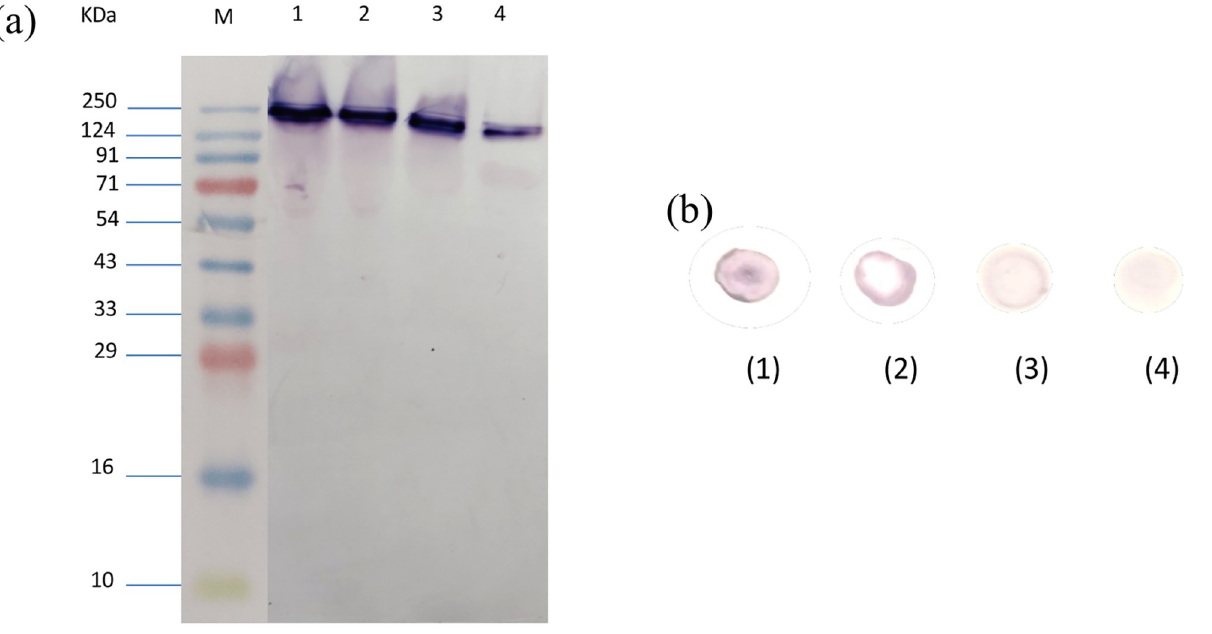
Fig 7. Representative image of the zymographic profile (a) of the mitochondrial MAO-A of F . gigantica on treatment with different concentrations of clorgyline (Lane 2: 30 μ M, Lane 3: 60 μ M and Lane 4: 90 μ M) and control without inhibitor (Lane 1). Dot blot assay of whole homogenate of F . gigantica samples treated with different concentrations of clorgyline (b) 1. Control 2. 30 μ M 3. 60 μ M 4. 90 μ M. All these results confirmed a concentration dependent decrease in the activity of MAO-A with an increase in the inhibitor dose from 30 to 90 μ M